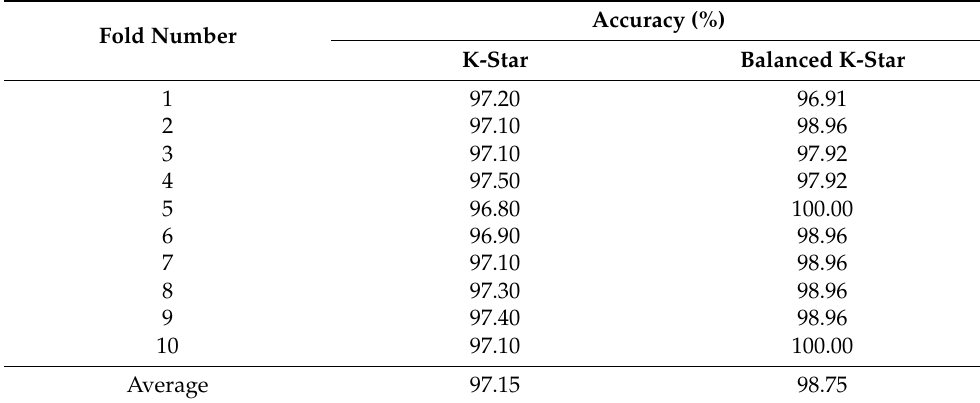
Table 4. Comparison of standard K-Star and the proposed Balanced K-Star in terms of accuracy.